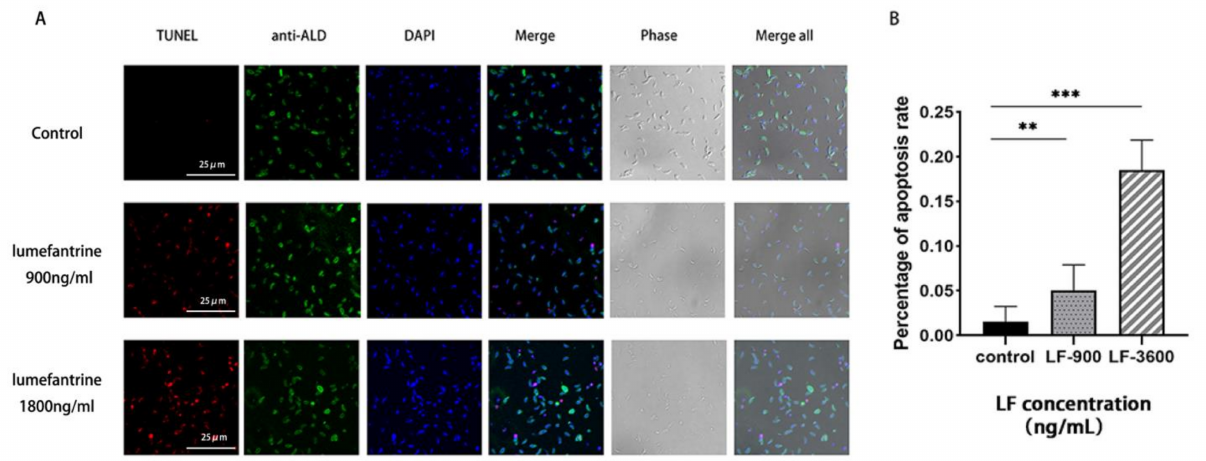
Figure 5. TUNEL assay to investigate apoptosis induced by lumefantrine. ( A ) Observation of DNA breakage under confocal microscopy caused by lumefantrine treatment. RH T. gondii in Vero cells were treated with lumefantrine (900 ng/mL or 1800 ng/mL) for 24 h and harvested for TUNEL test. Red signal indicated DNA damage. Green fluorescence was the result of staining of T. gondii cytoplasm using anti-TgALD antibody. The blue fluorescence was nuclei staining with DAPI. ( B ) Determination of the apoptosis rate using TUNEL. The ratio of the number of DNA-damaged parasites to the total number of parasites was defined as the apoptotic rate. With the increase of lumefantrine concentration, the apoptosis rates increased. Data shown here were the averages of the three biological repeats. The error bar was the standard deviation (** p ≤ 0.01, *** p ≤ 0.001) and t -test was used for statistical